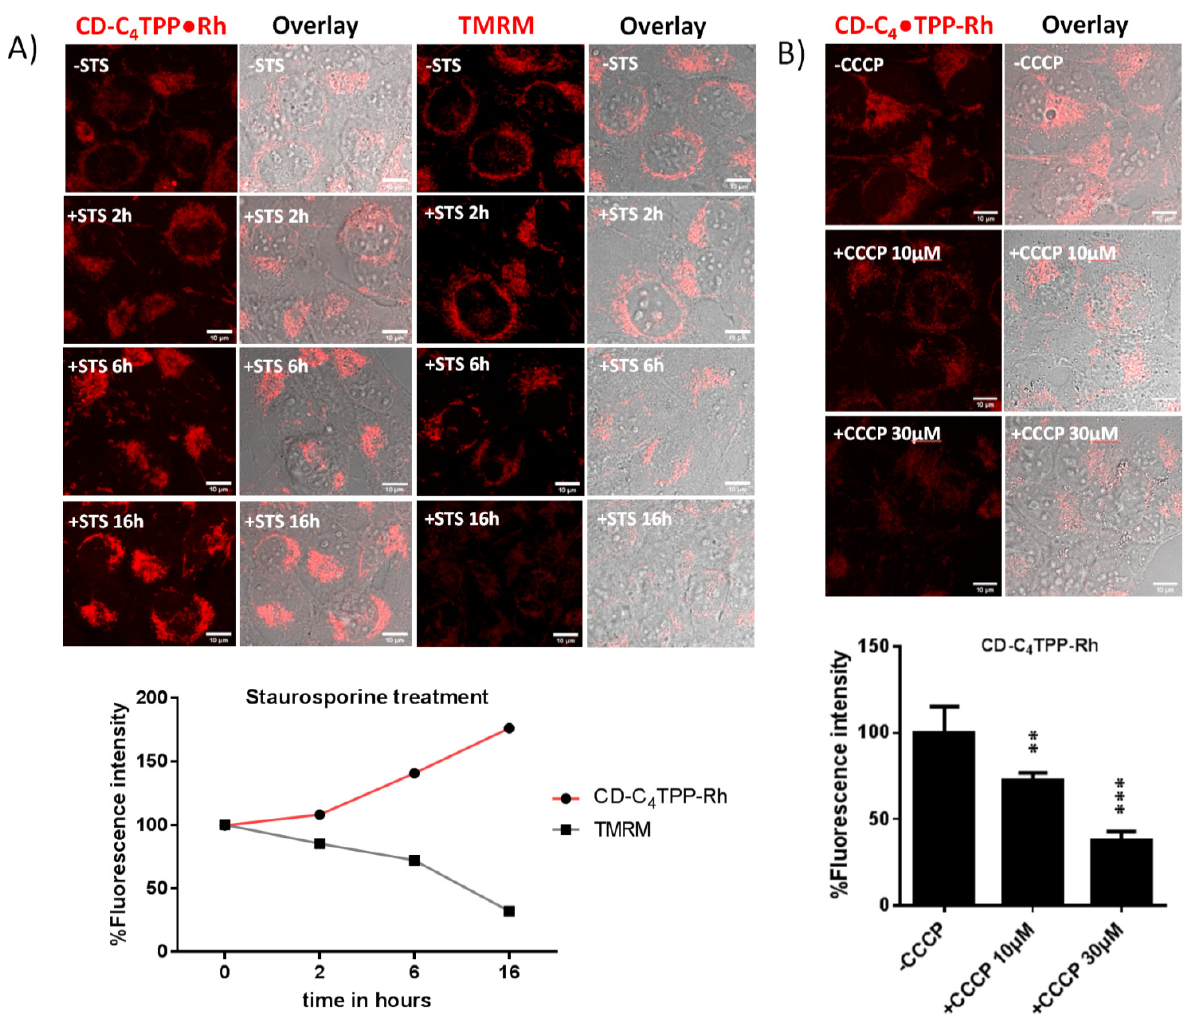
Figure 7. Staining patterns of CD-C4TPP•Rh in live MDA-MB-231 cells under various treatments and the corresponding fluorescence quantification over time. ( A ) Cells were treated with CD-C4TPP•Rh 50 μ g/mL for 3 h, and TMRM 10 nM for 30 min following treatment with 2 μ M of staurosporine (STS) for 2, 6 and 16 h. The respective graph depicts % quantification of fluorescence intensities over time. ( B ) Cells were treated with CD-C4TPP•Rh 50 μ g/mL for 3 h following treatment with 10 and 30 μ M of CCCP for 30 min. Respective graphs depict % quantification of fluorescence intensities. Overlay depicts bright field and red channel. Scale bar: 10 μ m. Results are expressed as the mean ± standard error for at least three independent experiments and were analyzed using the Student t -test. Significance is relative to respective controls. ** p > 0.01, *** p > 0.001.